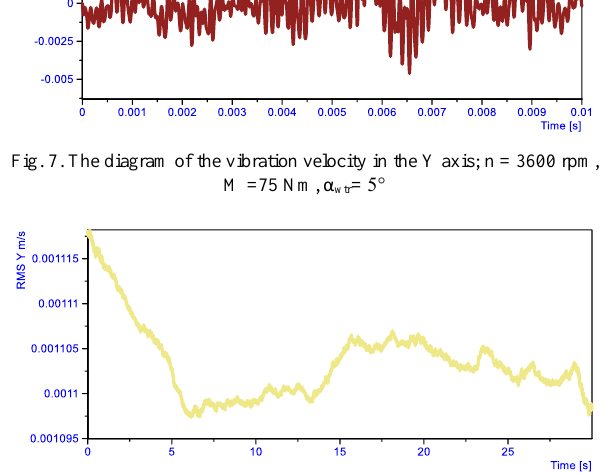
Fig. 8. The diagram of the effective RMS velocity of vibrations along the Y axis; n = 3600 rpm, M =75 Nm, α wtr = 5°